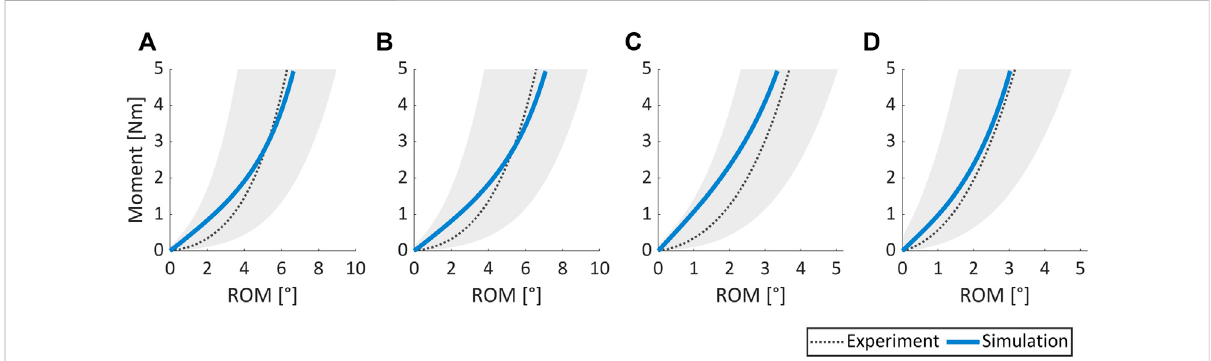
FIGURE 8 Comparison of experimental results vs. numerically simulated responses for (A) fl exion, (B) extension, (C) lateral bending, and (D) axial rotation load cases. The shaded grey area covers the range of mean experimental ROM (dotted black line) ± one standard deviation. Experimental data were obtained from 31 non-degenerated spine segments (Widmer et al.,